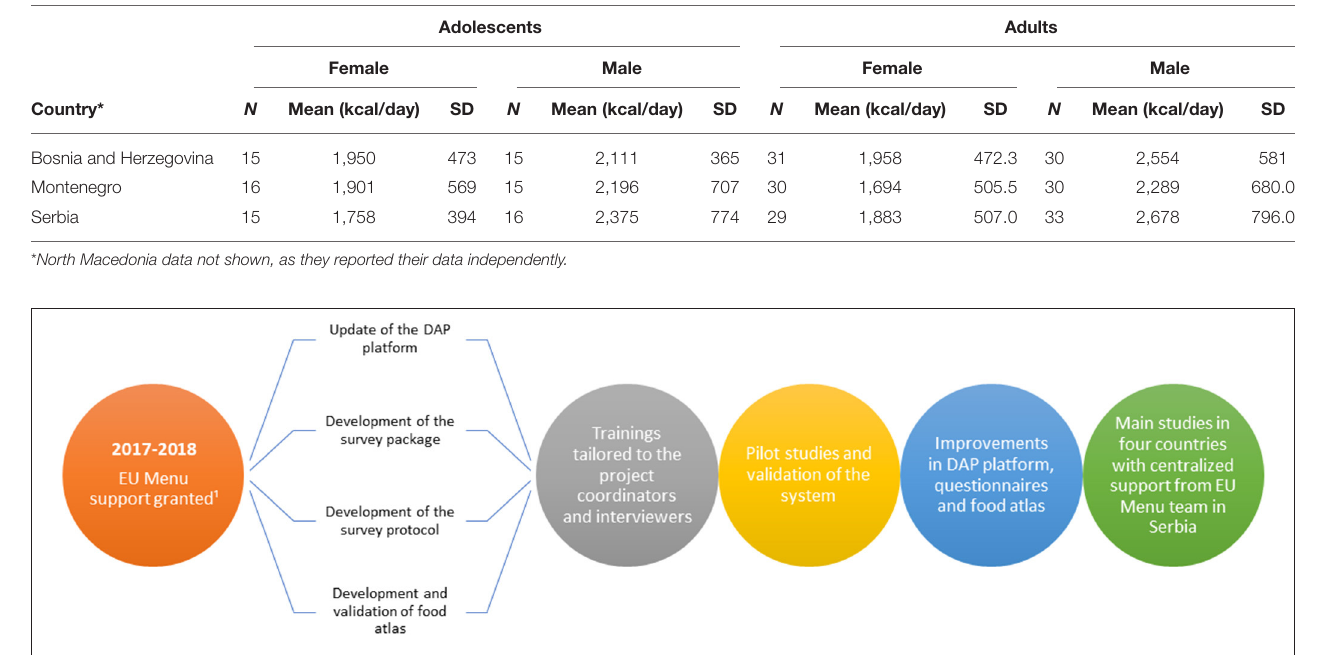
FIGURE 3 | Schematic overview of step-wise approach to implementation of the harmonized food consumption survey in Balkan countries. ¹“The adults’ survey,” including subjects from 10 to 74 years old (supported in Serbia, Bosnia and Herzegovina and Montenegro); “The children’s survey,” including subjects from three months up to 9 years old, 2017–2021 (supported in Serbia, North Macedonia, and Montenegro).